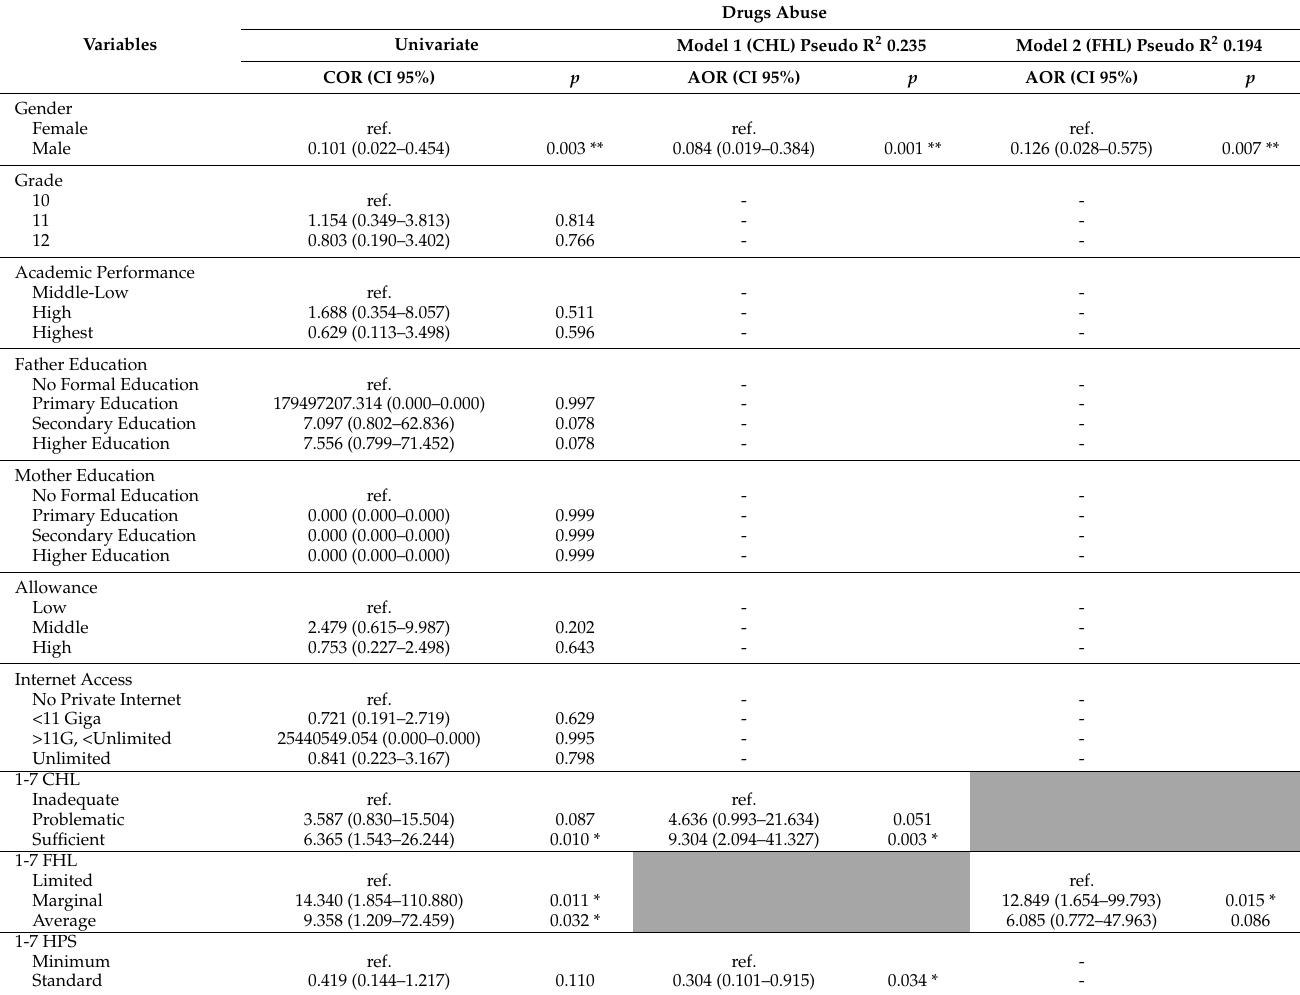
Table 8. Univariate and multivariate logistic regression of drug abuse with socioeconomic factors in the CHL and FHL models.